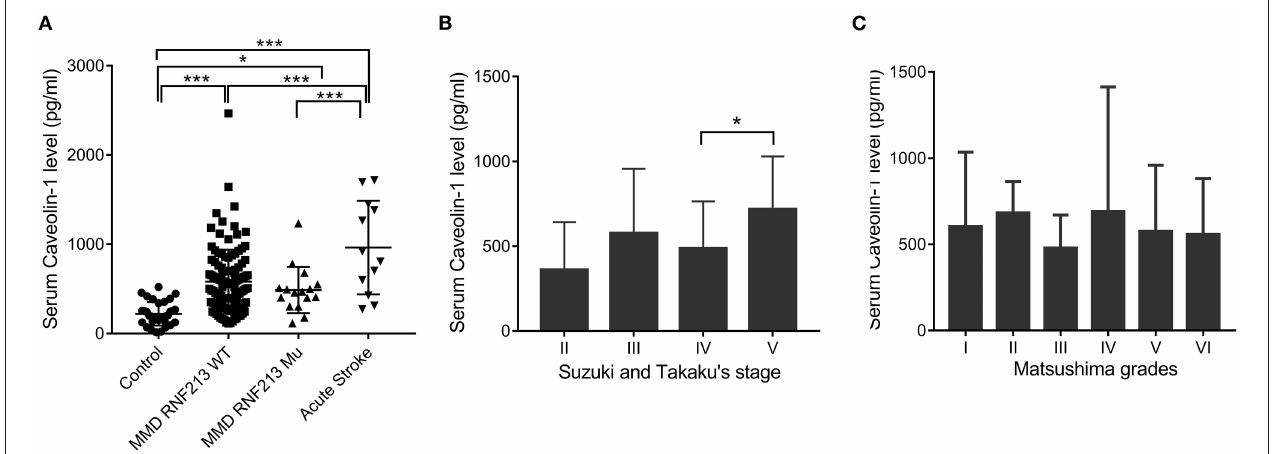
FIGURE 1 | Serum caveolin-1 (Cav-1) levels in patients with moyamoya disease (MMD), acute stroke, and healthy controls. (A) Serum Cav-1 levels of patients with MMD [with or without the Ring Finger Protein 213 ( RNF213 ) mutation], age-matched controls, and patients with acute stroke. (B) Serum Cav-1 levels of patients with MMD categorized by Suzuki and Takaku’s stages. Stage V demonstrated higher Cav-1 levels than patients in stage IV. (C) Serum Cav-1 levels of patients with MMD categorized by the Matsushima grades. * p < 0.05, *** p < 0.001. WT, wild type; Mu, mutation.